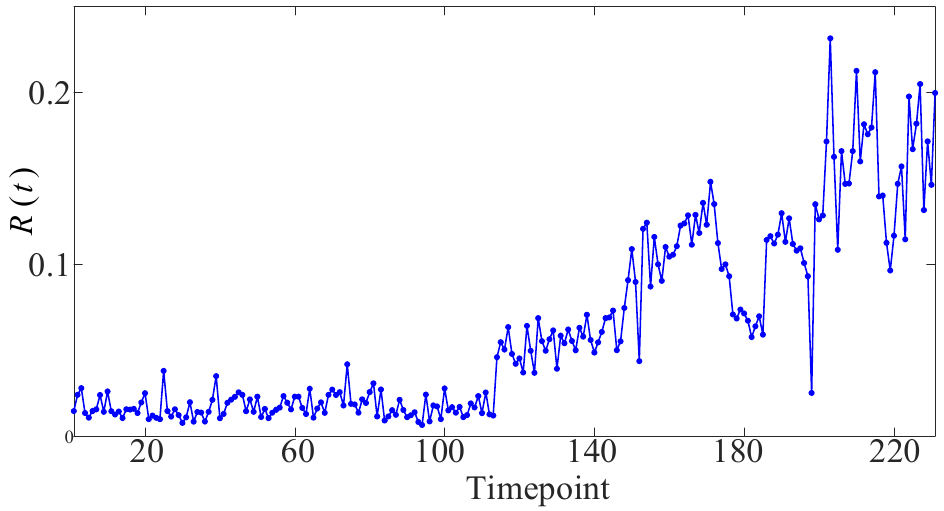
Figure 11. The sequence of CDI in the time–frequency domain of the unit R ( t ) .